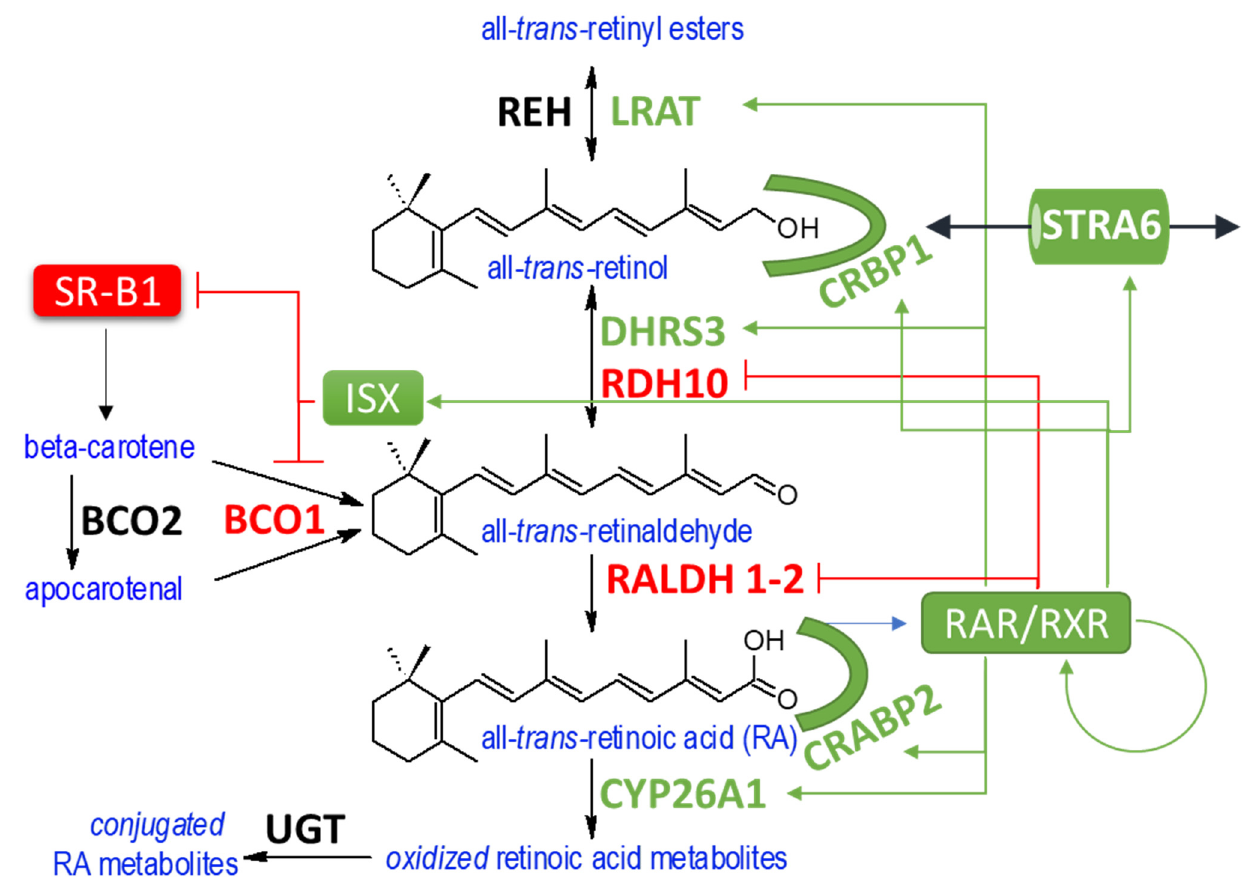
Figure 3. Factors involved in the feedback regulation in metabolism of RA. The influence of RA on genes involved in the pathway of conversion of vitamin A precursors to RA is shown only for retinoid genes currently known to respond to RA. Other enzymes, transporters and binding proteins involved in retinoid metabolism are not shown but are listed in text and enclosed references. Names of enzymes, transporters and binding proteins involved in retinoid metabolism are listed in red if downregulated by RA, or green if upregulated by RA, and in black if regulation by RA is currently not known.